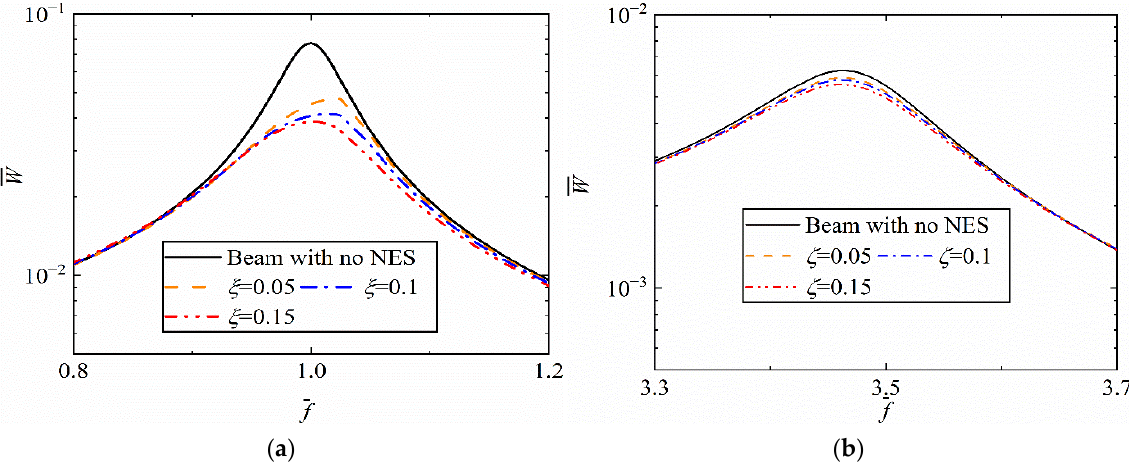
Figure 6. ( a ) Response at the first resonance frequency under varying damping ratio; ( b ) response at the second resonance frequency under varying damping ratio.